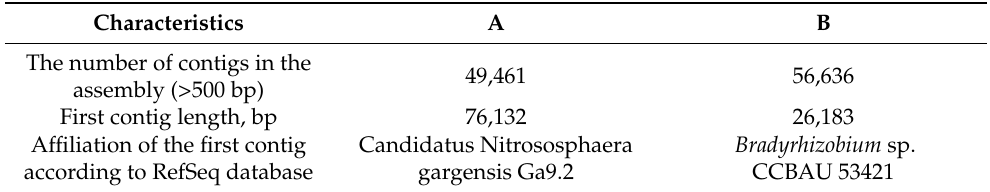
Table 3. Characteristics of